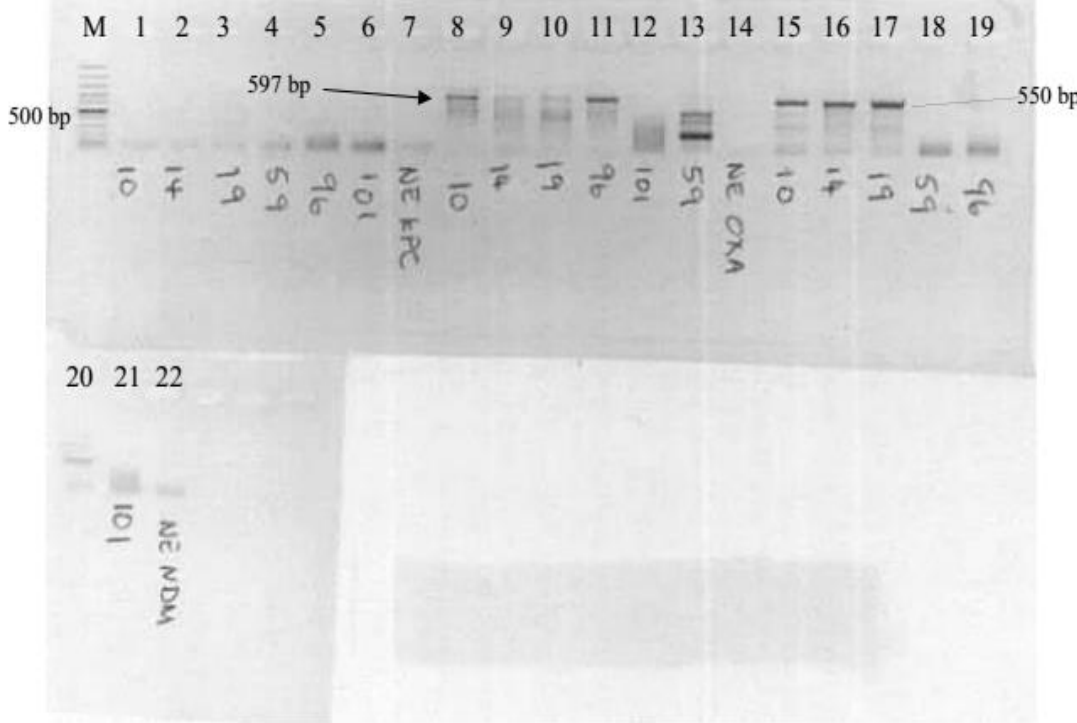
Plate I. Agarose gel eletrophoregram of amplicons of carbapenemase genes. Lane M is 100 bp molecular ladder. Lanes 8, 9, 10 and 11 had bands corresponding to 597 bp ( bla OXA) while lanes 15, 16 and 17 had bands corresponding to 550 bp ( bla NDM). Lanes 7, 14 and 22 were negative